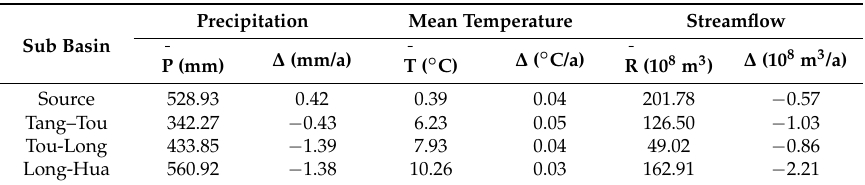
Figure 5. MK results of the trend analysis for annual precipitation, mean temperature, and streamflow in four regions of YRB. Table 1. Average of annual precipitation, mean temperature, and streamflow and their change rate in four regions of YRB.